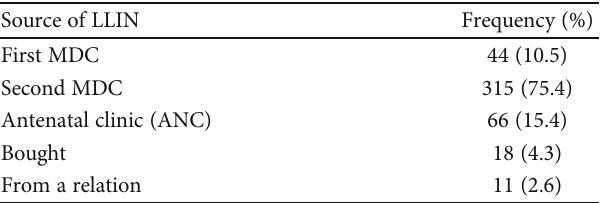
Table 2: Sources of